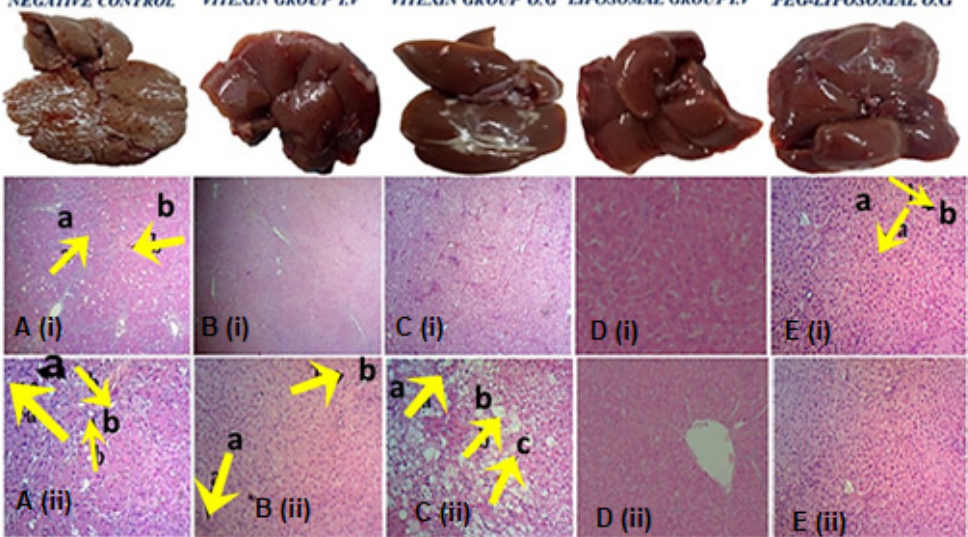
Figure 7. Liver histopathology of ( A ) Negative control, and after treatment with ( B ) Vitexin (intra- venous (IV) treated group, ( C ) Vitexin Oral gavage (OG) treated group, ( D ) Vitexin liposomes (VLPs) IV treated group, ( E ) Polyethylene glycol coated vitexin liposomes (PEG-VLPs) OG treated group. In spleen tissue histology of the vitexin, IV treated group, hyperplasia of white pulp, congestion, and hyperplasia of red pulp were observed. In the vitexin O.G treated group, germinal centers were prominent, and there was light fibrosis of red pulp but still decreased follicles and congestion of red pulp was seen. In VLPs IV treated group, follicles of variable sizes and increased in number with 50% of germinal centers were prominent. In